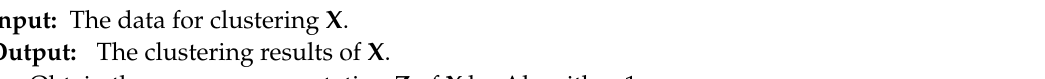
Algorithm 2 Subspace clustering based on LLE-SSC and